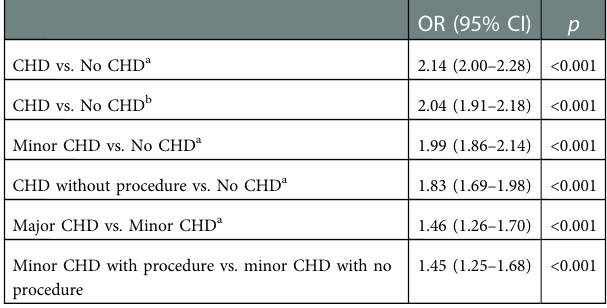
TABLE 3 Odds ratio (OR) of receiving special